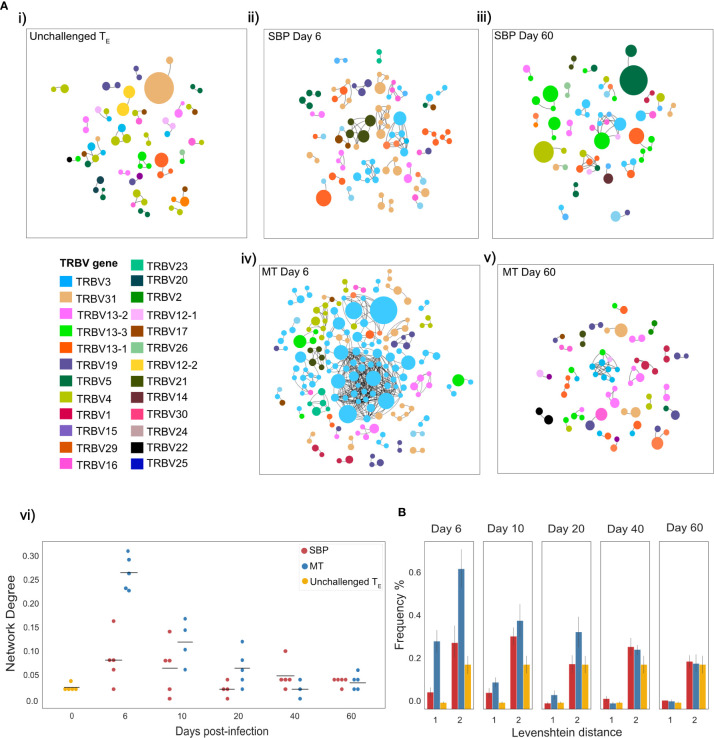
Mosquito-transmitted (MT) acute repertoires have greater clonal network connectivity. (A) (i–v) Networks showing the top 100 most abundant CDR3 amino acid sequences in replicate repertoires within a Levenshtein distance of 1 of each other. For T-cell receptors (TCRs) a Levenshtein distance of 1 represents 1 amino acid mismatch (insertion, deletion or substitution) between CDR3 sequences. Each node represents a TCR clone as defined by CDR3 amino acid sequence, with node size indicating proportion of repertoire occupied by clone. Nodes are colored according to TRBV-gene usage. An edge is drawn between nodes if within a Levenshtein distance of 1, with unconnected nodes not depicted, (vi) network degree (mean number of edges per node) for each individual TE repertoire network. (B) Frequency (%) of individual CDR3 sequence pairwise-comparisons, within the top 100 most abundant CDR3 sequences of each individual TE repertoire, that are within a Levenshtein distance of 1 and 2.